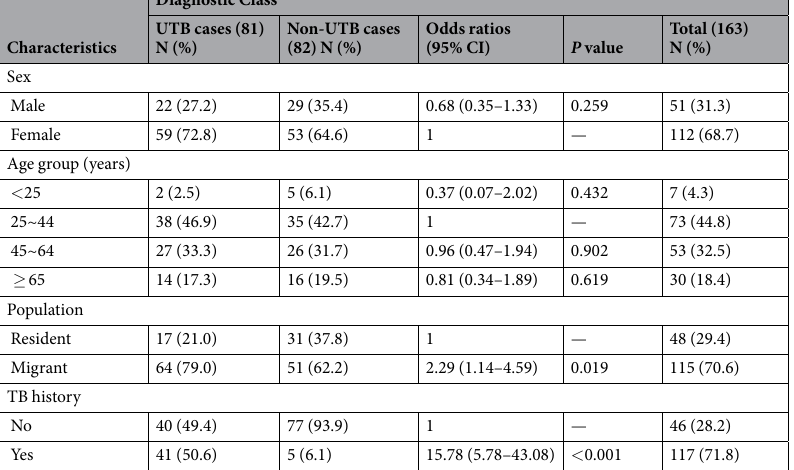
Table 3. Demographic Characteristics of clinical diagnosed urinary tuberculosis patients enrolled in this study. UTB: urinary